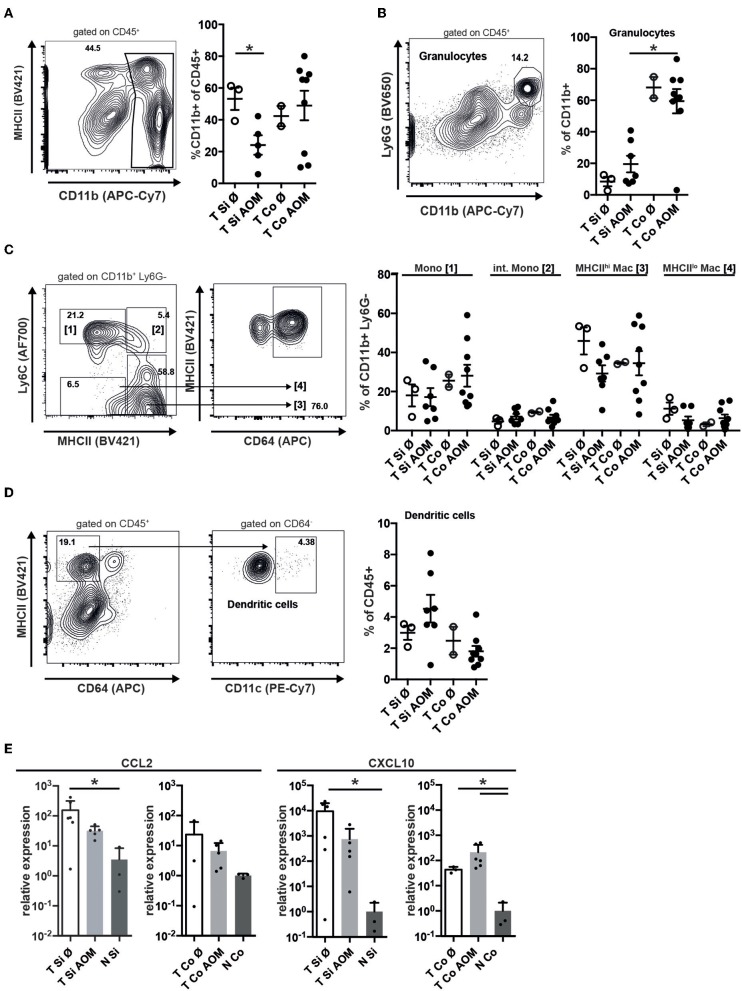
Accumulation of granulocytes in intestinal tumors correlates with chemokine expression and is enhanced in colon tumors. (A) Representative contour plot of intratumoral (AOM treated colon tumor) immune cells stained for MHCII and CD11b, showing the gating for CD11b+ cells. The percentages of CD11b+ cells of all CD45+ cells in Si and Co tumors of untreated and AOM treated Apc1638N/+ mice are shown in the graph. (B) Representative dot plot of intratumoral CD45+ immune cells stained for Ly6G and CD11b, showing the gating for CD11b+ Ly6G+ granulocytic cells. The percentages of CD11b+ Ly6G+ cells of all CD11b+ cells are shown in the graph. (C) Gating strategy for monocytes (Mono), intermediate monocytes (int. Mono), and MHCIIlo/hi macrophages within the intratumoral CD11b+ Ly6G− population. The percentages of the indicated populations within the CD11b+ Ly6G− cells are shown in the graph. (D) Gating strategy for intratumoral DCs and frequency of DCs within CD45+ cells. (A–D) Each symbol represents an individual mouse. Horizontal bars indicate mean, error bars indicate SEM, n = 2–9. (E) Relative mRNA expression of the chemokines CCL2 and CXCL10 in tumors and normal intestinal tissue from AOM-treated and untreated Apc1638N/+ mice measured by qRT-PCR [fold-change compared to normal tissue, log(10) scale]. Symbols indicate individual mice, horizontal bars: mean, error bars: SEM, n = 3–6, unpaired, two-tailed t-test. *p < 0.05.